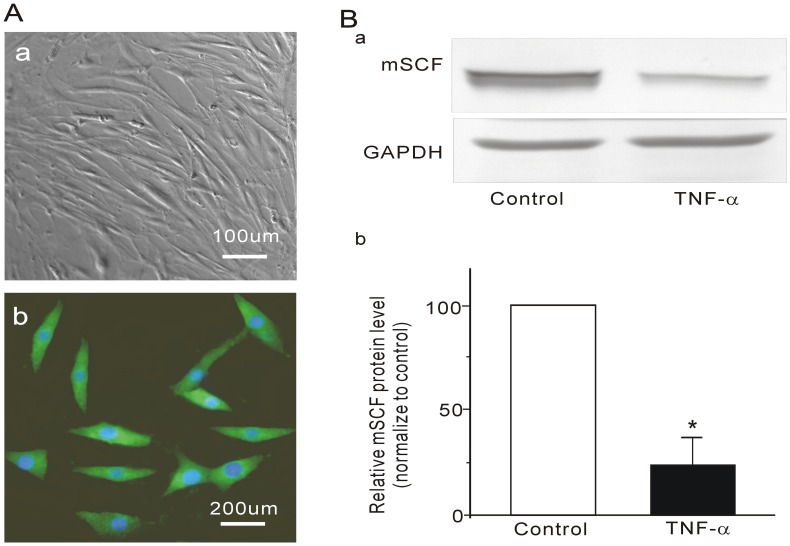
Effect of TNF-α on mSCF expression in cultured intestinal smooth muscle cells.Primary cultures of the intestinal smooth muscle cells are shown in (A). Intestinal smooth muscle cells displayed typical spindle-shaped morphology and a “hill-and-valley” pattern of growth (A-a). Immunofluorescence analysis of cultured intestinal smooth muscle cells revealed smooth muscle α-actin (visualized with FITC-conjugated secondary antibody). DAPI was used to stain the nuclei (A-b). Western blotting revealed that expression of mSCF was significantly decreased in cultured intestinal smooth muscle cells treated with TNF-α (10 ng/ml; B). A typical Western blot result is shown in (B-a). Bands were quantified using densitometry (compared with GAPDH and normalized to control; B-b). **P<0.01, n = 8.